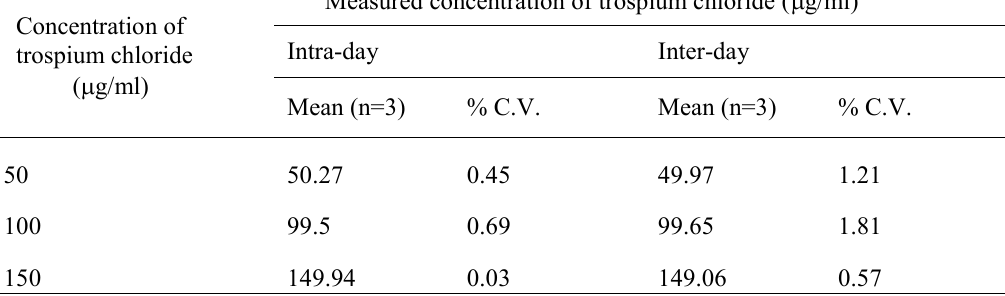
Table 2 : Precision of the proposed HPLC